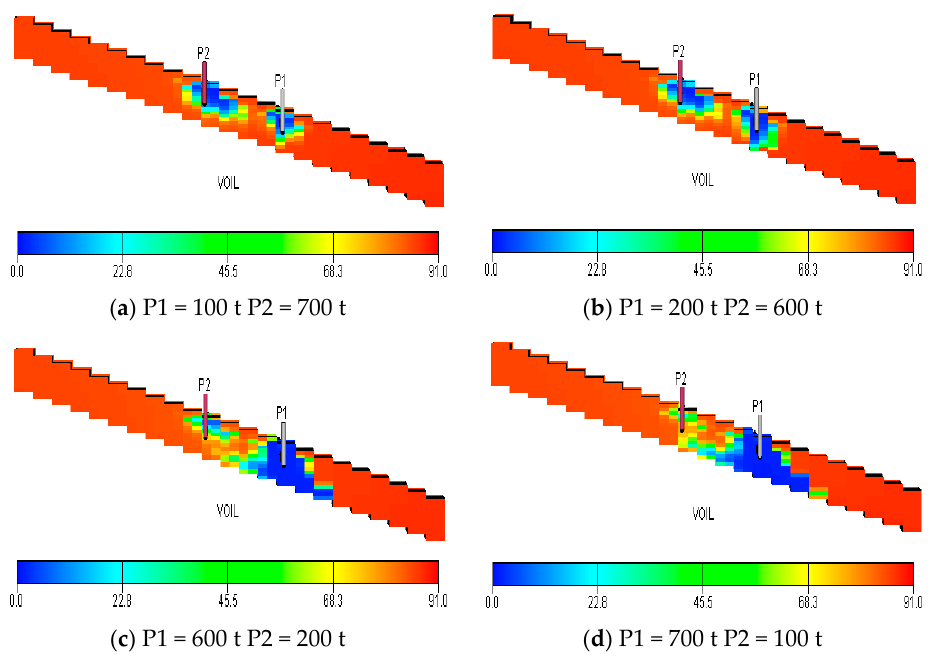
Figure 16. Influence of CO 2 injection ratio on the oil increment.